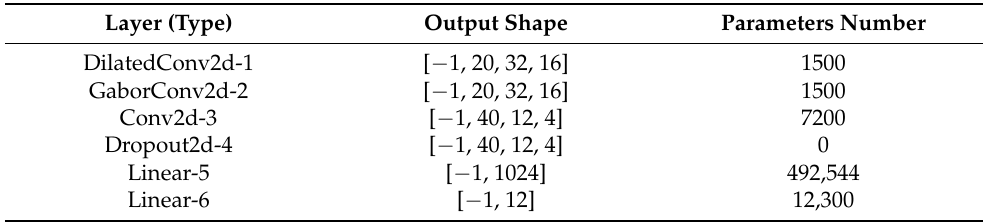
Table 6. The architecture of the CNN used in the comparison.